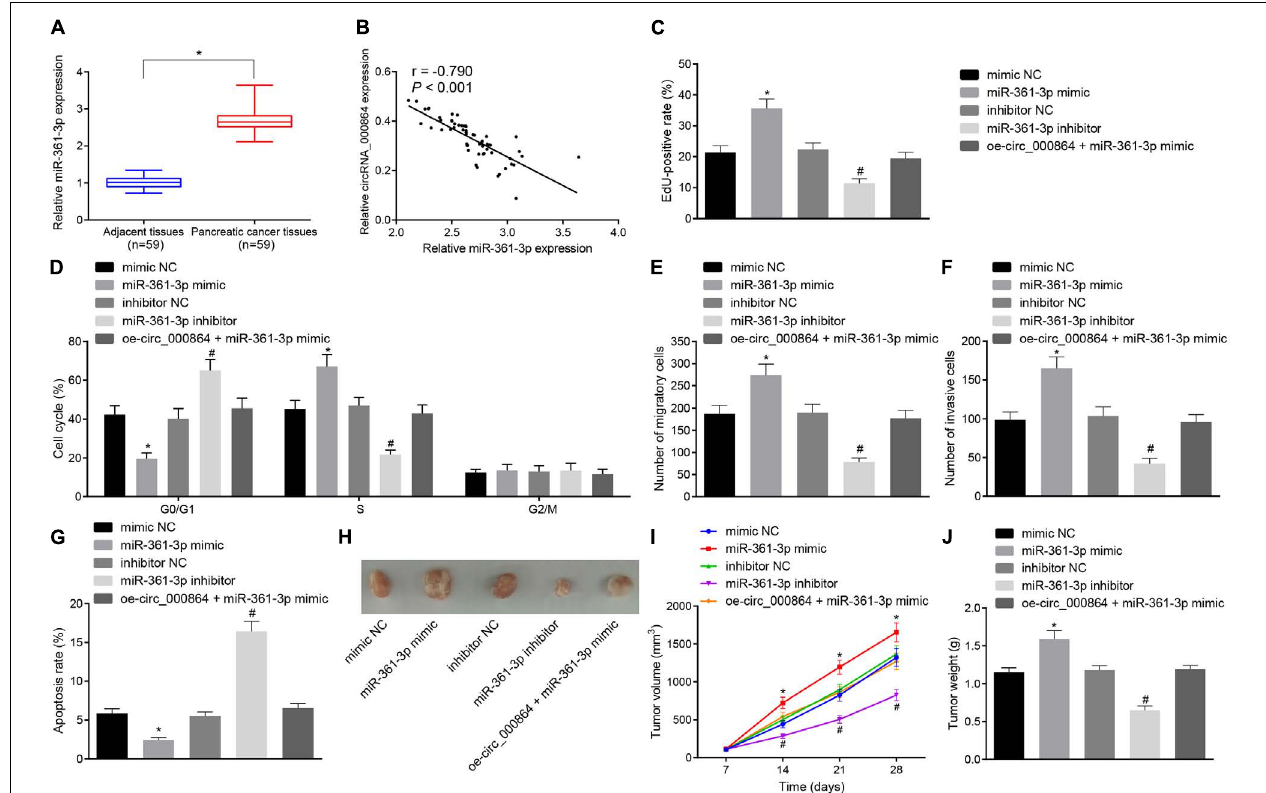
FIGURE 5 | Downregulation of miR-361-3p contributes to inhibition of proliferation, migration, invasion, and antiapoptosis of pancreatic cancer cells. (A) RT-qPCR detection of relative expression levels of miR-361-3p in pancreatic cancer tissues and adjacent normal tissues normalized to U6 ( n = 59). (B) Pearson correlation analysis of the correlation between circRNA_000864 and miR-361-3p ( n = 59). AsPC-1 cells were transfected with mimic-NC, miR-361-3p mimic, inhibitor-NC, miR-361-3p inhibitor, or oe-circRNA_000864 + miR-361-3p mimic. (C) AsPC-1 cell proliferation detected by using EdU assay. (D) AsPC-1 cell cycle distribution detected by flow cytometry. (E) AsPC-1 cell migration detected by Transwell assay. (F) AsPC-1 cell invasion detected by Transwell assay. (G) AsPC-1 cell apoptosis detected by flow cytometry. Mice were treated with mimic-NC, miR-361-3pmimic, inhibitor-NC, miR-361-3p inhibitor, or oe-circRNA_000864 + miR-361-3pmimic. (H) Representative images of xenograft tumor in nude mice ( n = 6). (I) Tumor volume of mice ( n = 6). (J) Tumor weight of mice ( n = 6). * p < 0.05 vs. adjacent normal tissues or AsPC-1 cells or mice treated with mimic-NC. # p < 0.05 vs. AsPC-1 cells or mice treated with inhibitor-NC. The measurement data were expressed as sample mean ± standard deviation. Data of (A) were compared by the paired t -test, data of (I) were compared by repeated measures ANOVA (Tukey’s post hoc test), and data of (J) were compared by one-way ANOVA (Tukey’s post hoc test). The remaining statistical results were expressed as sample mean ± standard deviation and analyzed by using a one-way ANOVA (Tukey’s post hoc test). The cell experiment was conducted three times